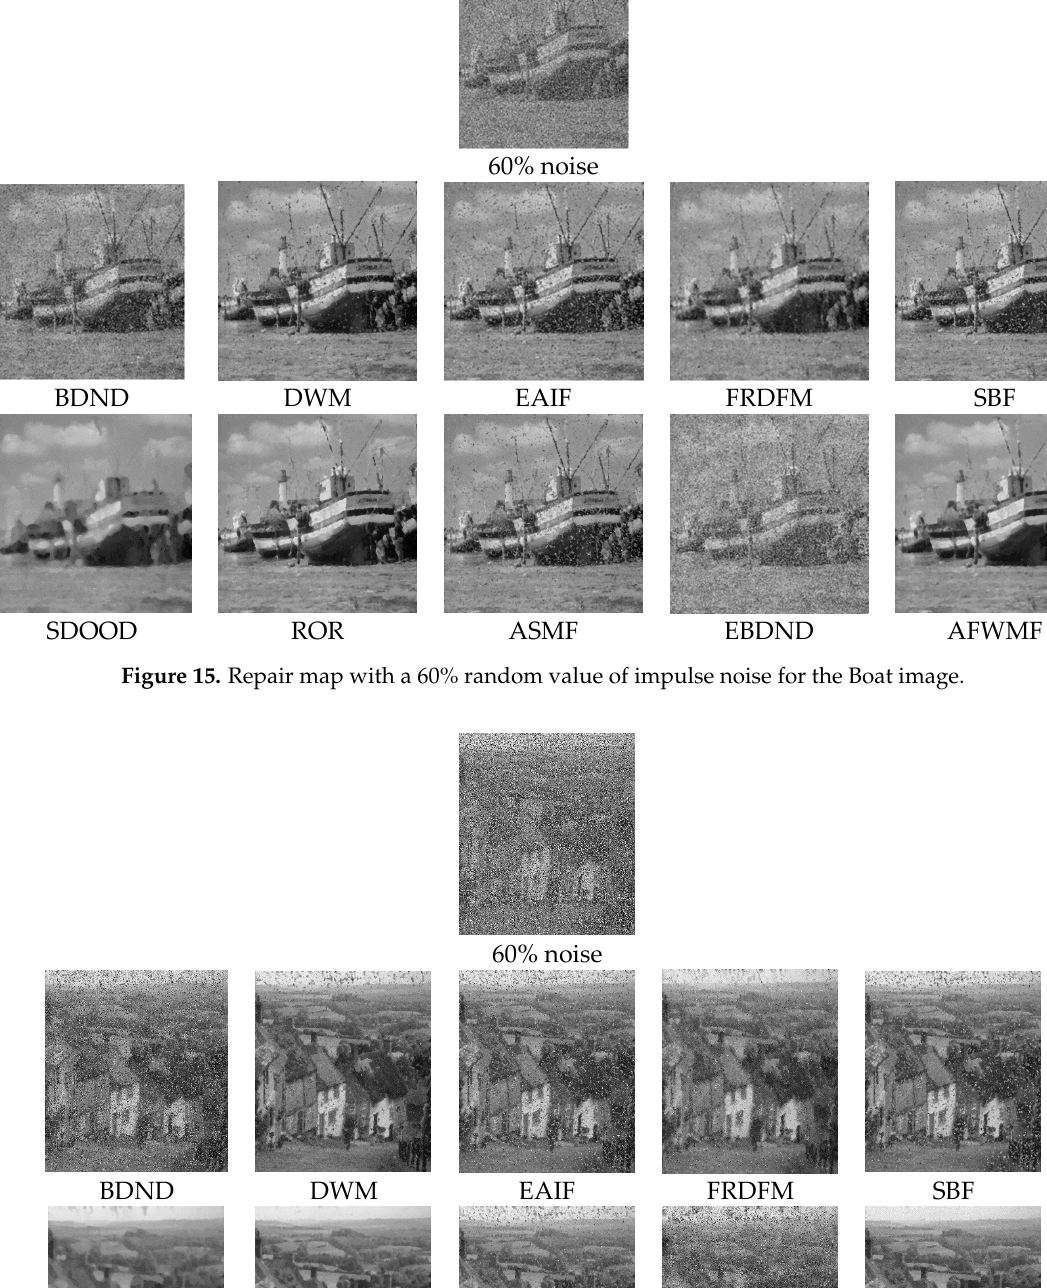
Figure 14. Repair map with a 60% random value of impulse noise for the Peppers image.